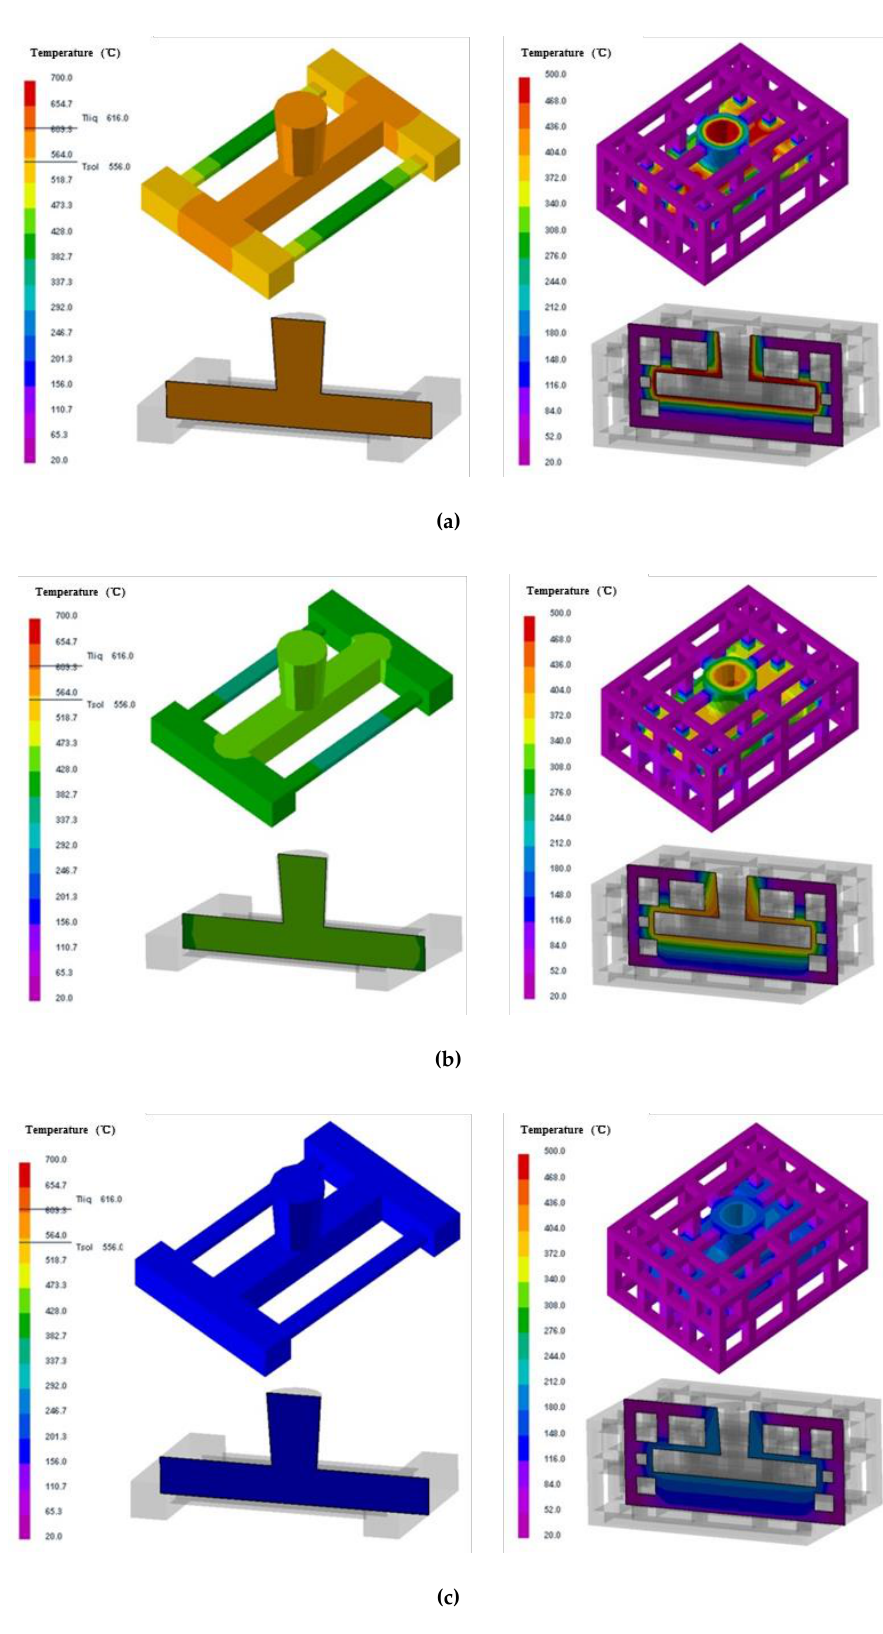
Figure 7. The temperature fields of the skeletal sand mold and casting: ( a ) 500 s; ( b ) 1500 s and ( c ) 4500